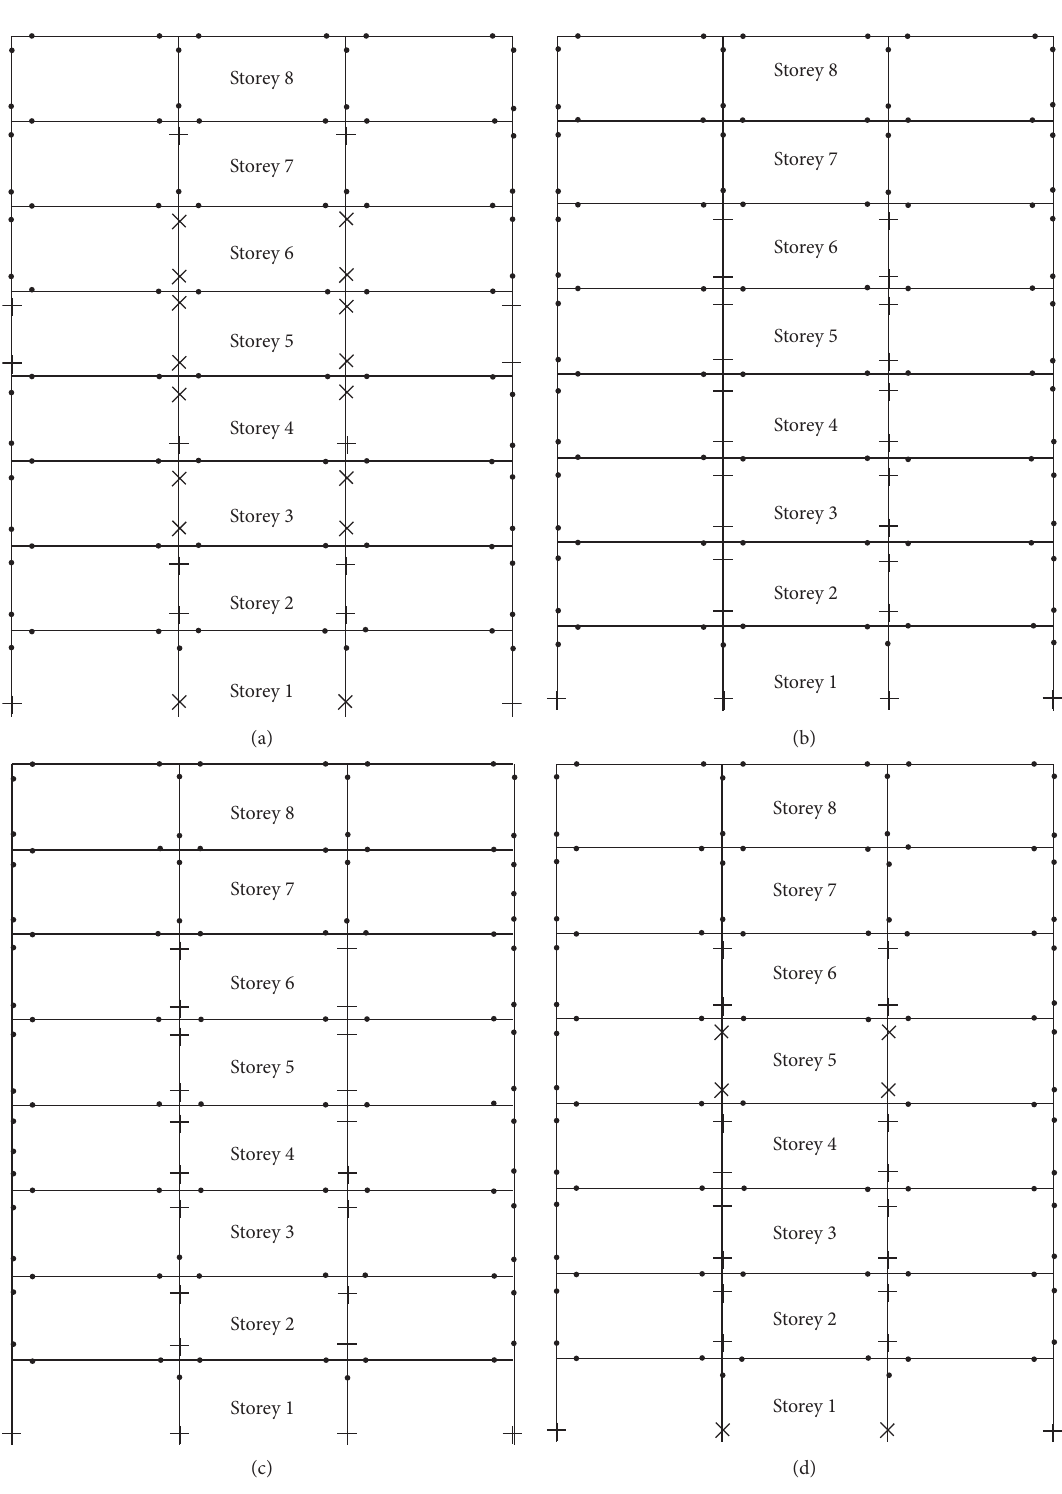
Figure 19: Damage of the 8-storey frame: (a) original, (b) RS1, (c) RS2, and (d)